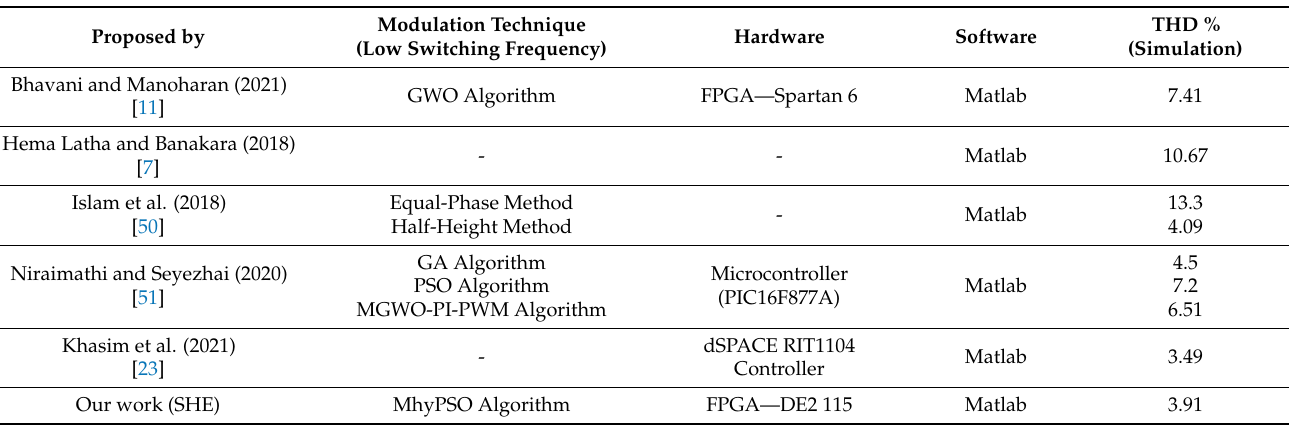
Table 12. Comparison of THD of a 21-level multilevel inverter using a low-switching-frequency modulation technique.